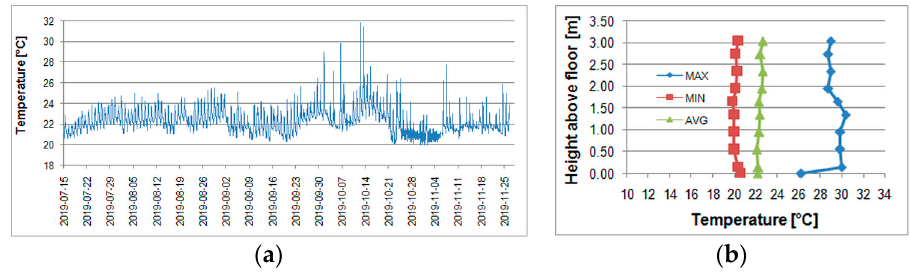
Figure 9. ( a ) Temperature T3; ( b ) vertical profile of air temperature without 8 points with t > 30 °C.